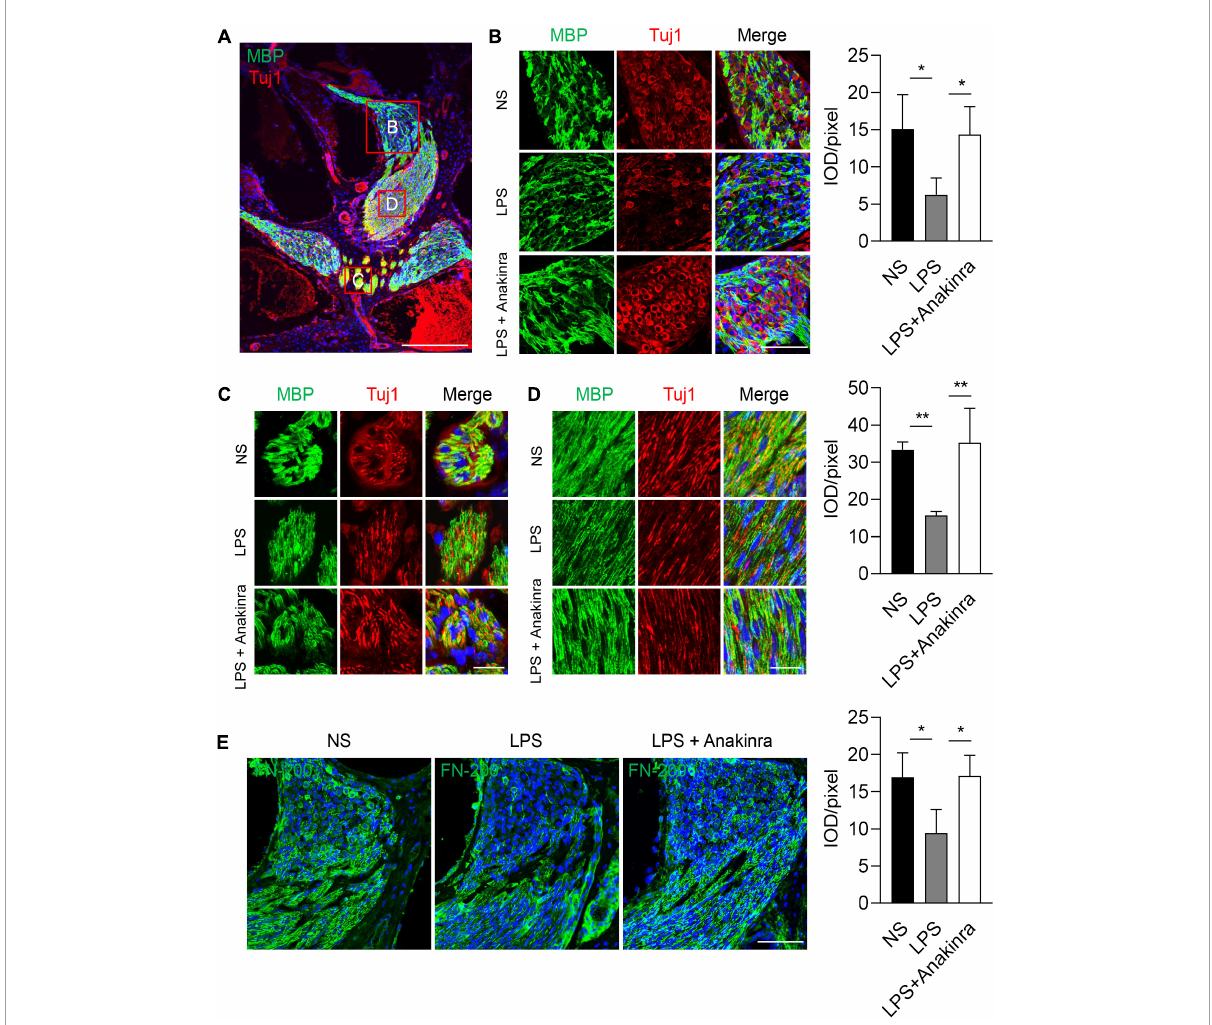
FIGURE6 Anakinra protected LPS-induced neurons and myelin sheath damage. (A) Low-power view of mid-modiolar cochlear sections from LPS group illustrating auditory nerve fibers in different regions stained positively for MBP (green) and Tuj1 (red). Nuclei were counterstained with DAPI (blue), scale bar = 500 µ m. (B) Confocal images of SGNs for MBP (green), Tuj1 (red), and DAPI (blue) within the medial portion of Rosenthal’s canal in the upper turns of mice. Analysis of images is shown at right, quantifying the expression of MBP per pixel ( n = 3), scale bar = 50 µ m. (C, D) MBP + nerve fibers are illustrated in central portions of the auditory nerve in the ears. Analysis of images is shown at right, quantifying the expression of MBP per pixel ( n = 3), scale bar = 12.5 µ m. (E) Immunofluorescence staining for FN-200 (green) and DAPI (bule) in cochlear axis. Analysis of images is shown at right, quantifying the expression of FN-200 per pixel ( n = 3), scale bar = 50 µ m. Tuj1, class III β -tubulin. Data are presented as mean ± SD. * p < 0.05, ** < 0.01. NS, 0.9% normal